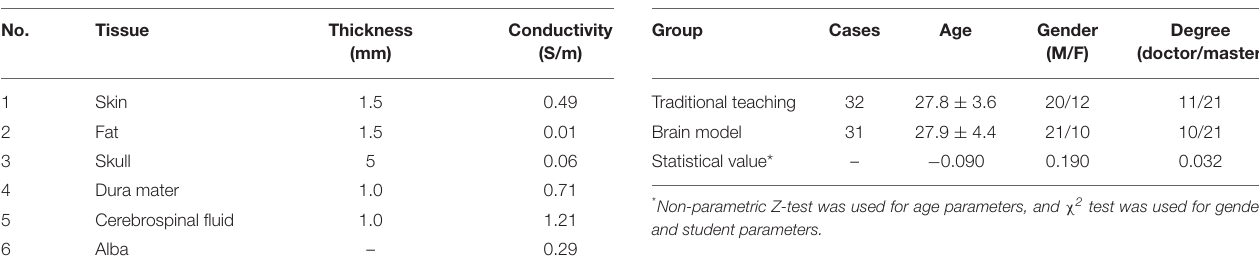
TABLE 1 | Parameters of brain tissue for the planar layered structure. TABLE 2 | Comparison of characteristics of enrolled